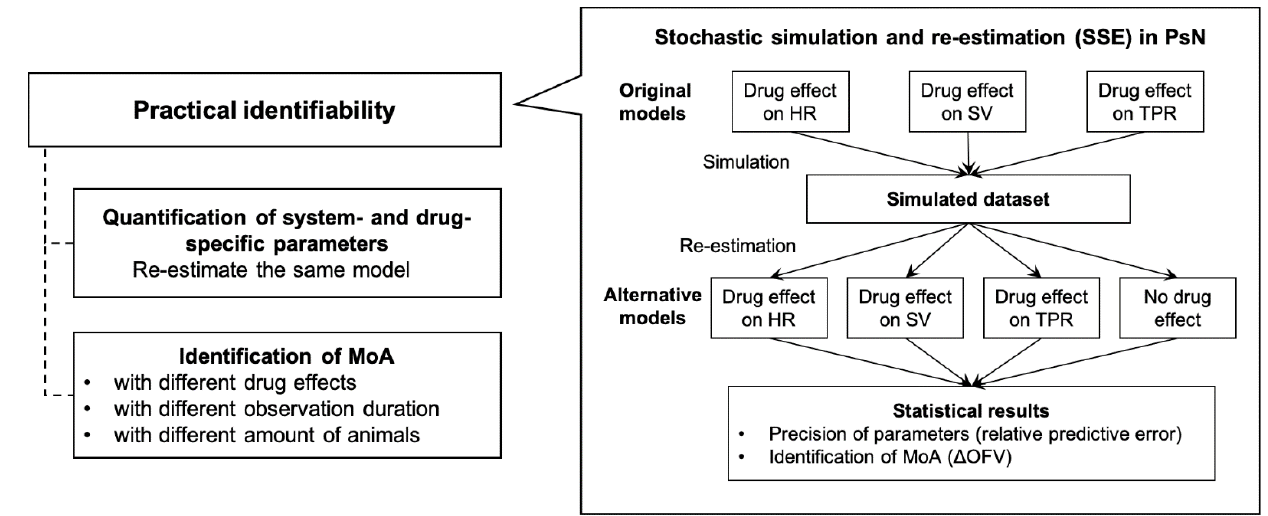
Figure 2. Overview identifiability analyses. SSE: stochastic simulation and re-estimation; PsN: Perl- speaks-NONMEM toolkit; HR: heart rate; SV: stroke volume; TPR: total peripheral resistance; MoA: mode-of-action; OFV: objective function value.